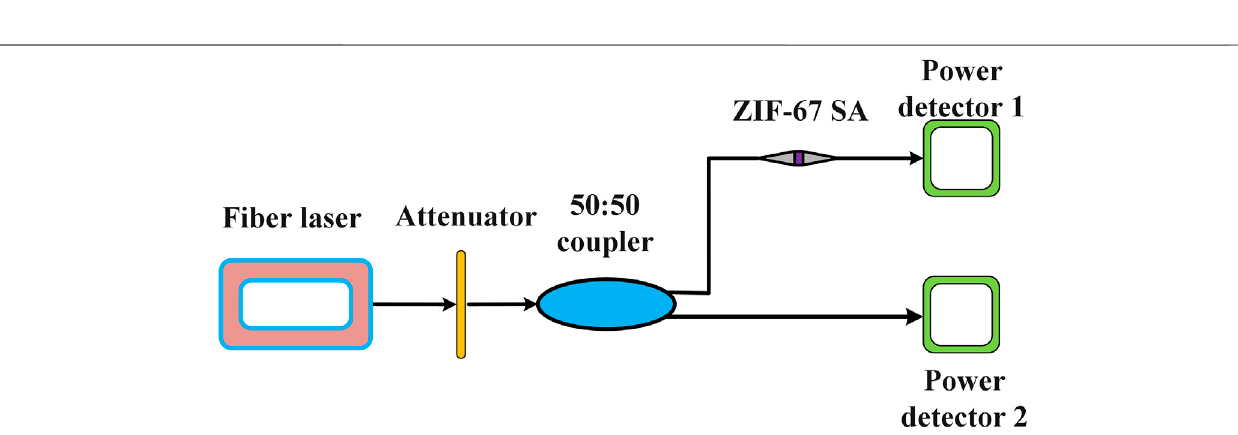
Frontiers in Physics |